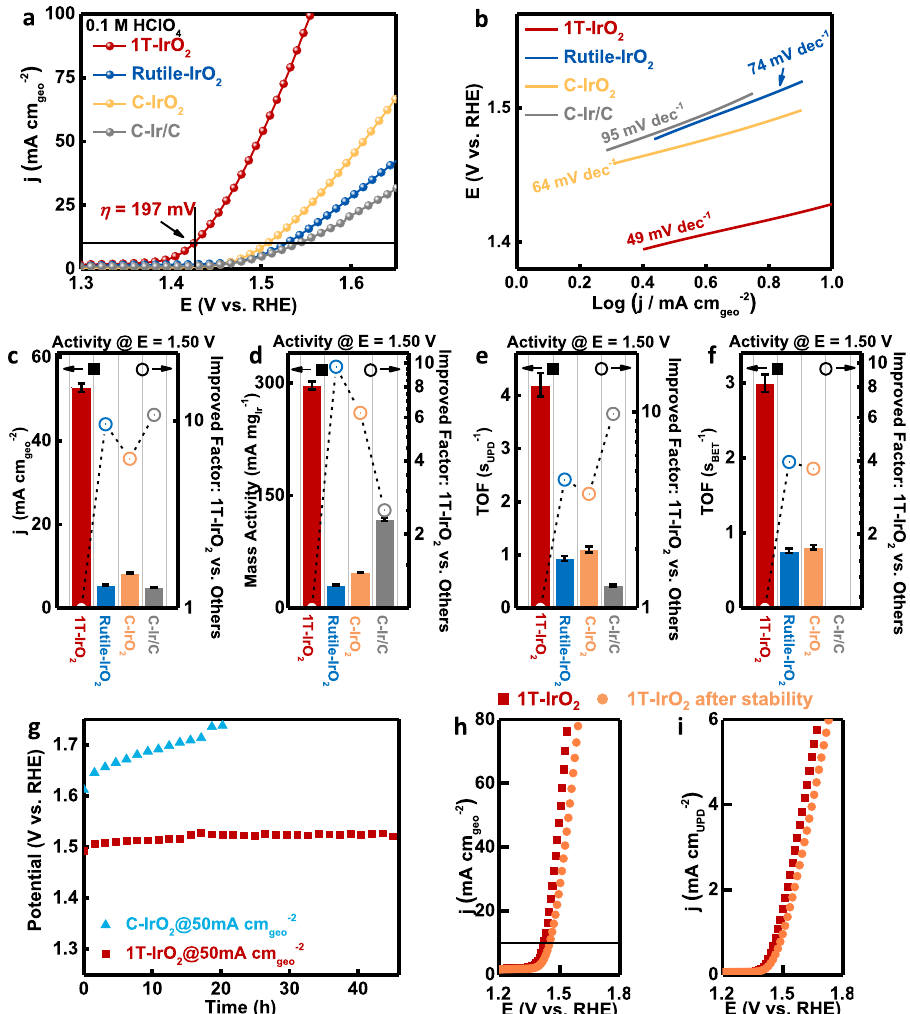
Fig. 4 OER performance of 1T-IrO 2 . a Polarization curves of 1T-IrO 2 , Rutile-IrO 2 , and commercial catalysts (C-IrO 2 and C-Ir/C) in O 2 -saturated 0.1 M HClO 4 electrolyte with iR-correction, where 1T-IrO 2 deliver an overpotential of 197 mV to achieve the current density of 10 mA cm geo − 2 . b Tafel plots obtained from the polarization curves in a. c – f Comparison of geometric activities, mass activities, UPD-based TOF, and BET-based TOF values at 1.50 V vs. RHE for 1T-IrO 2 , Rutile-IrO 2 , C-IrO 2 , and C-Ir/C. g Chronopotentiometry performance under a high constant current density of 50 mA cm geo − 2 for 1T-IrO 2 and C-IrO 2 , where 1T-IrO 2 maintain high electrochemical activity. h The geometric polarization curves and i UPD-based polarization curves of 1T-IrO 2 before and after stability test under the high current density of 50 mA cm geo − 2 , where the change of UPD-based active area-based activity in 1T-IrO 2 is very weak. Error bars are means± SD ( n = 3